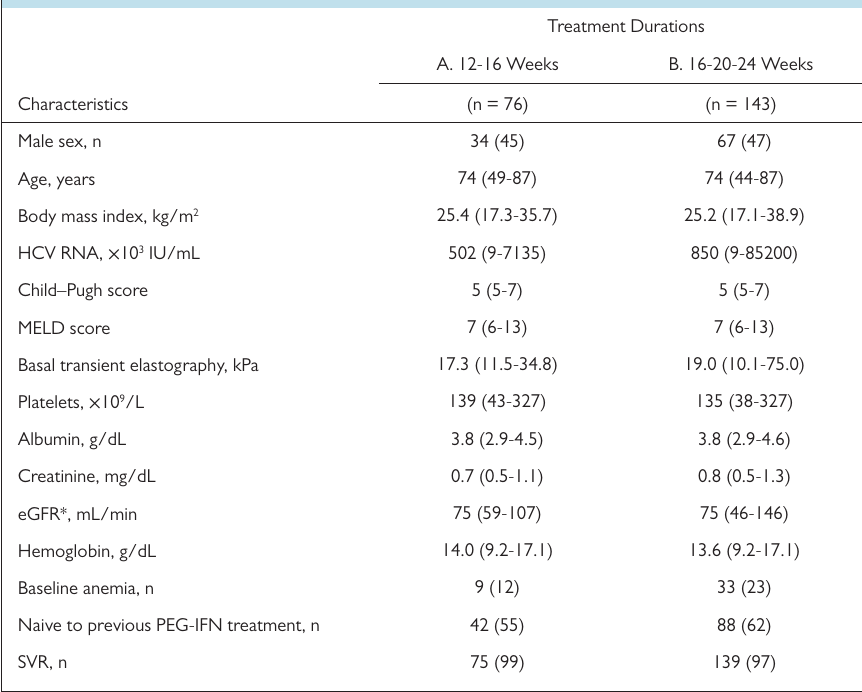
Table 5. Main Baseline Demographic and Clinical Parameters of the Patients Who Completed the Planned Treatment Grouped for 12 and 16 Weeks (Panel A) and 16, 20, and 24 Weeks (Panel B) Treatment